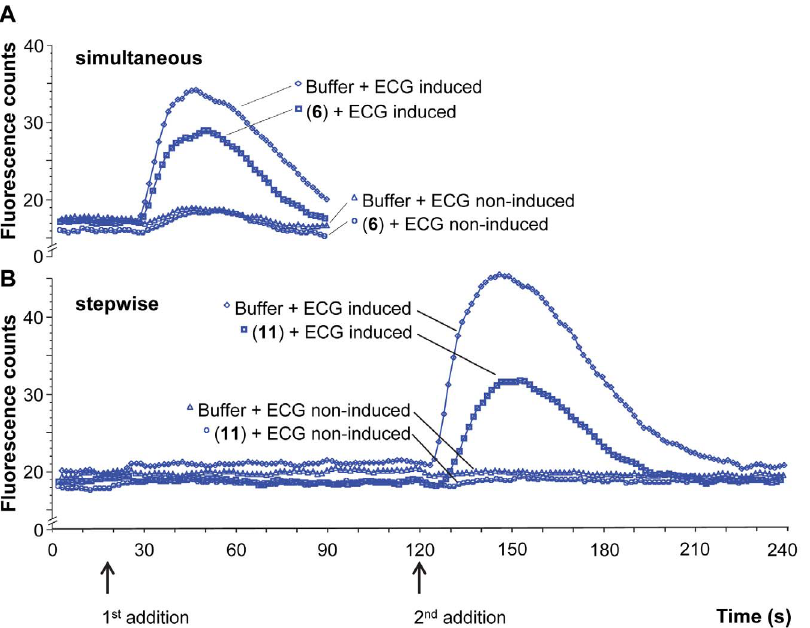
Figure 3. Fluorescent counts of ECG-induced calcium responses in cells expressing hTAS2R39 (induced) and non-expressing hTAS2R39 (non-induced). A : Simultaneous addition of agonist (ECG 200 m M) and antagonist (4 9 -fluoro-6-methoxyflavanone ( 6 ) 16 m M) ( % ) versus the signal elicited by ECG (antagonist replaced by buffer, final concentration ECG 200 m M) ( e ). Non-induced cells: ECG 200 m M and 4 9 -fluoro-6- methoxyflavanone ( 6 ) 16 m M ( # ) and ECG 200 m M ( D ). B : Stepwise addition of first antagonist (arrow ‘‘1 st addition’’), and then agonist (arrow ‘‘2 nd addition’’) (1 st 6-methoxyflavanone ( 11 ) 500 m M, 2 nd ECG 200 m M) ( % )) versus agonist (1 st buffer, 2 nd ECG 200 m M) ( e ). Non-induced cells: 1 st 6- methoxyflavanone ( 11 ) 500 m M, 2 nd ECG 200 m M ( # ) versus 1 st buffer, 2 nd ECG 200 m M ( D ).